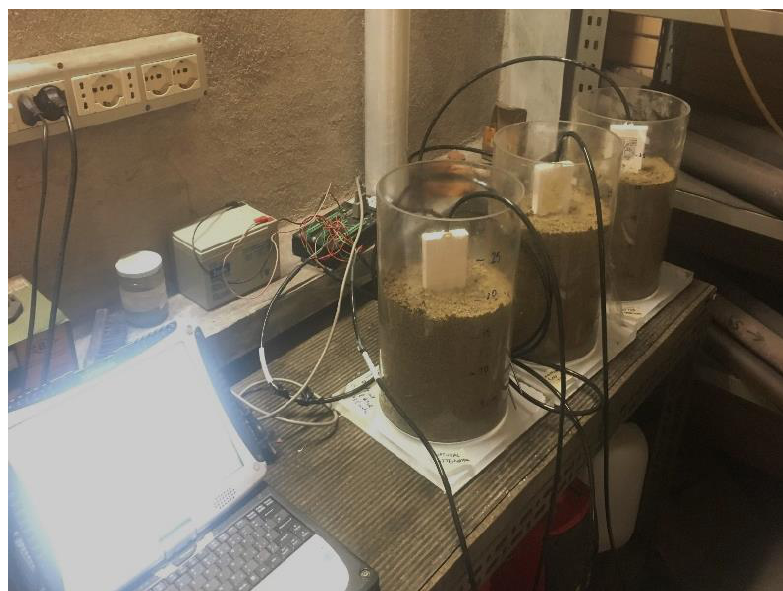
Figure 1. Experimental setup. The three columns are the three mesocosms. A white TDR probe is inserted in each of them and connected to the black datalogger behind.